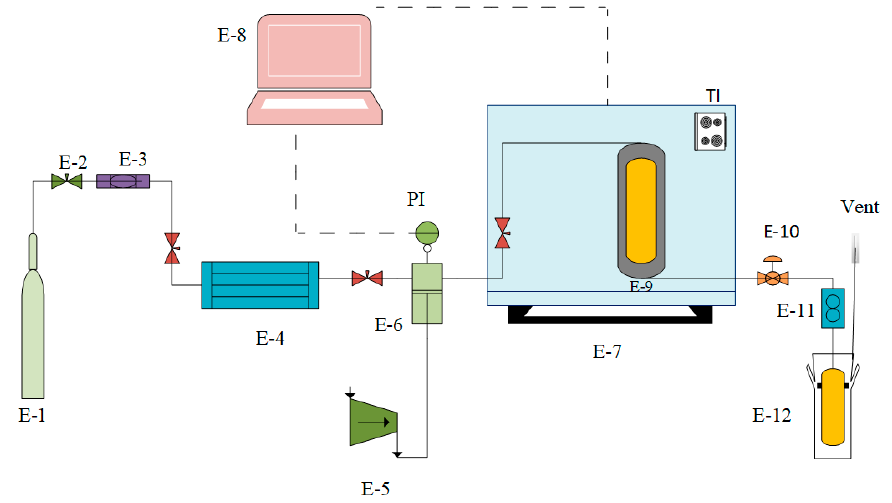
Figure 1. Schematic diagram of the supercritical CO 2 extraction set-up used for rosemary essential oil extraction. E-1: CO 2 cylinder, E-2: Needle valve, E-3: Filter, E-4: Refrigerator unit, E-5: High-pressure pump, E-6: Compressor, E-7: Oven, E-8: Automation system, E-9: Extraction cell, E-10: Back pressure, E-11: Micrometering valve, E-12: sampler.